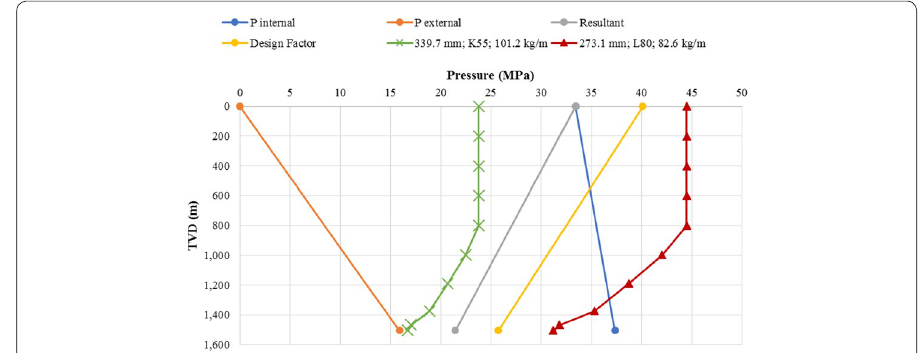
Fig. 8 Burst load for production casing and tieback casing of well HCE28B